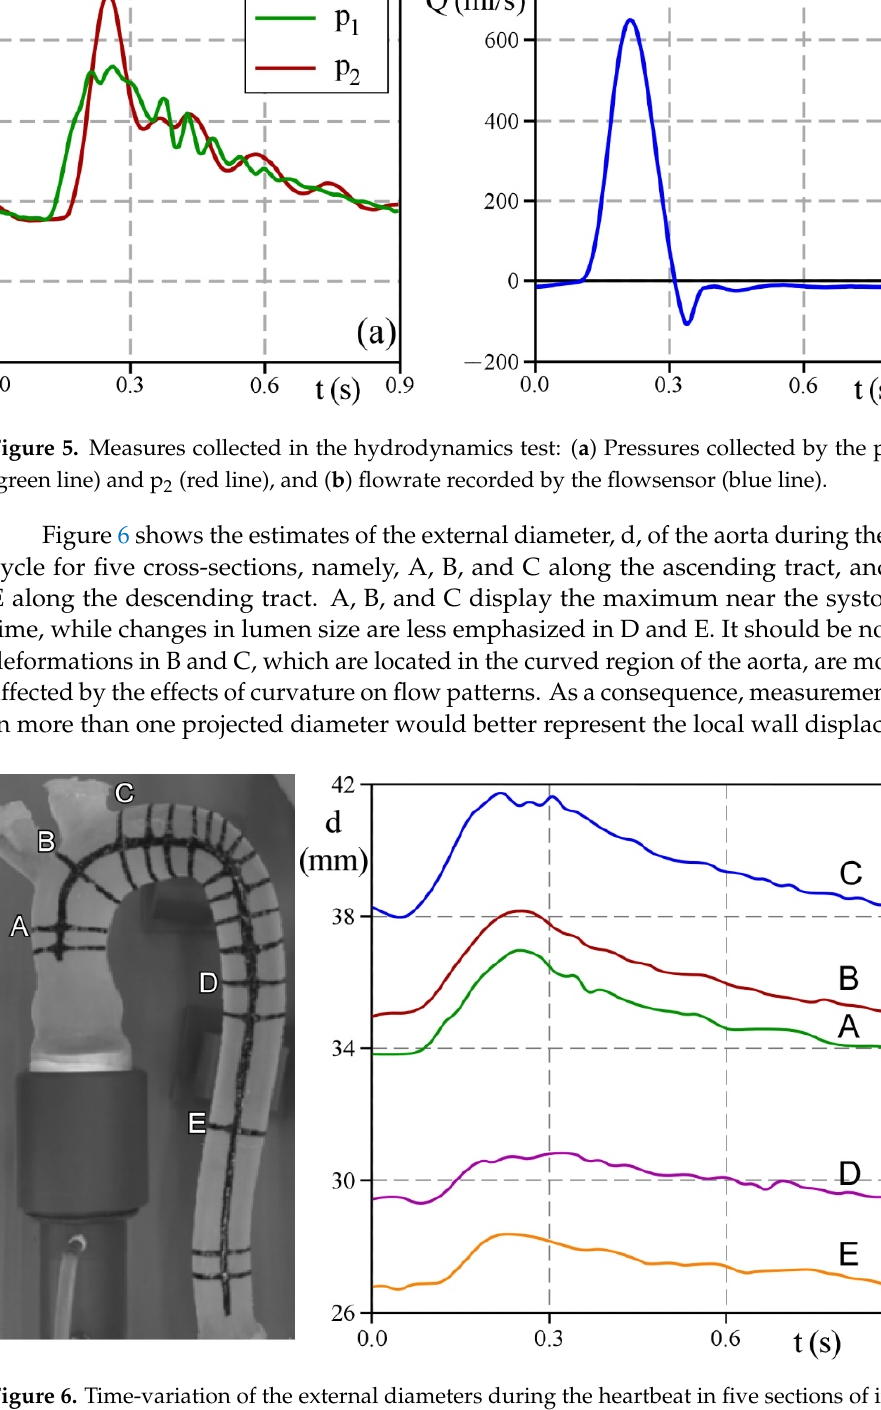
Figure 6. Time-variation of the external diameters during the heartbeat in five sections of interest.